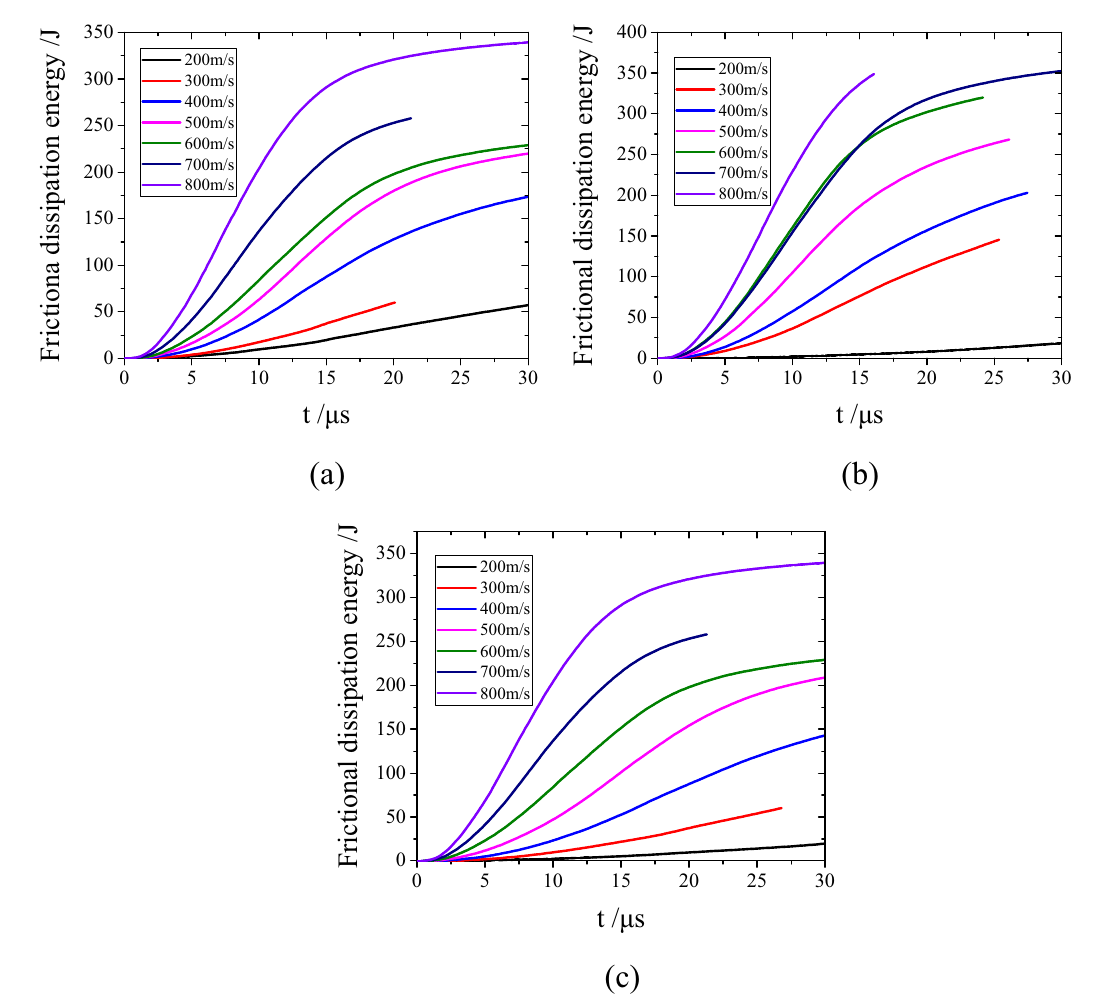
Figure 8: Frictional dissipation energy of simulation: ( a ) carbon, ( b ) Kevlar, and ( c ) hybrid.